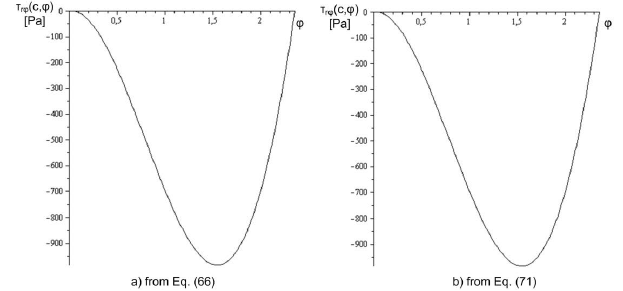
Figure 8: Plots of τ rφ ( c , φ ) for Example 1.